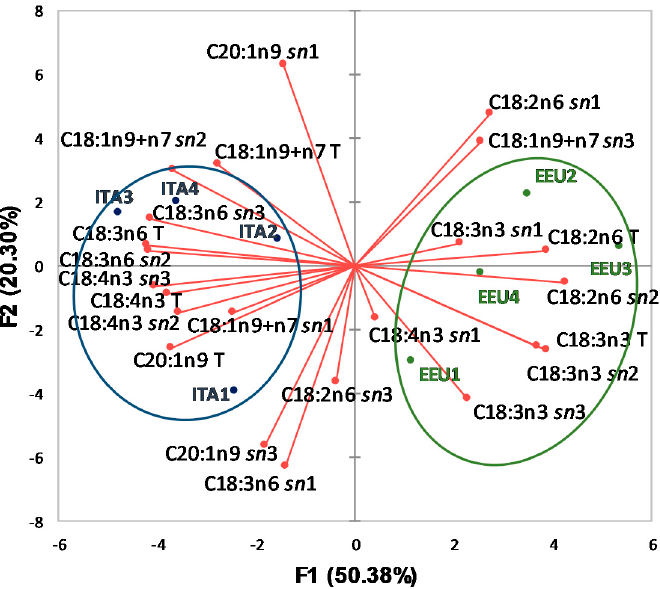
Figure 1. Plot of principal components obtained using total and intrapositional FA % compositions of TAG of HSO samples. ITA, Italian samples; EEU, Extra-European Union samples; C18:1n9+n7, oleic and octadecenoic; C20:1n9, gondoic; C18:2n6, linoleic; C18:3n3, α -linolenic; C18:3n6, γ -lino- leic; C18:4n3, stearidonic acids. The letter T after FA indicates that the variable refers to the